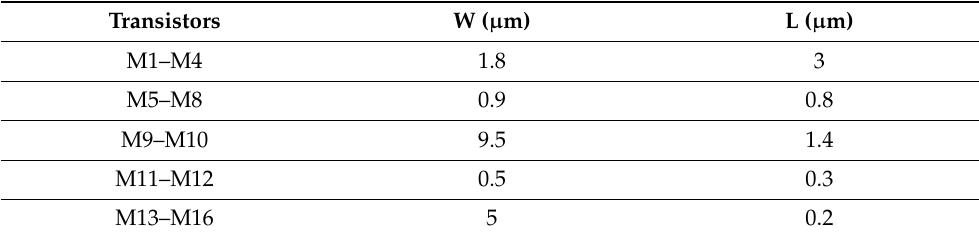
Table 1. Transistor sizing of the designed DVCC.